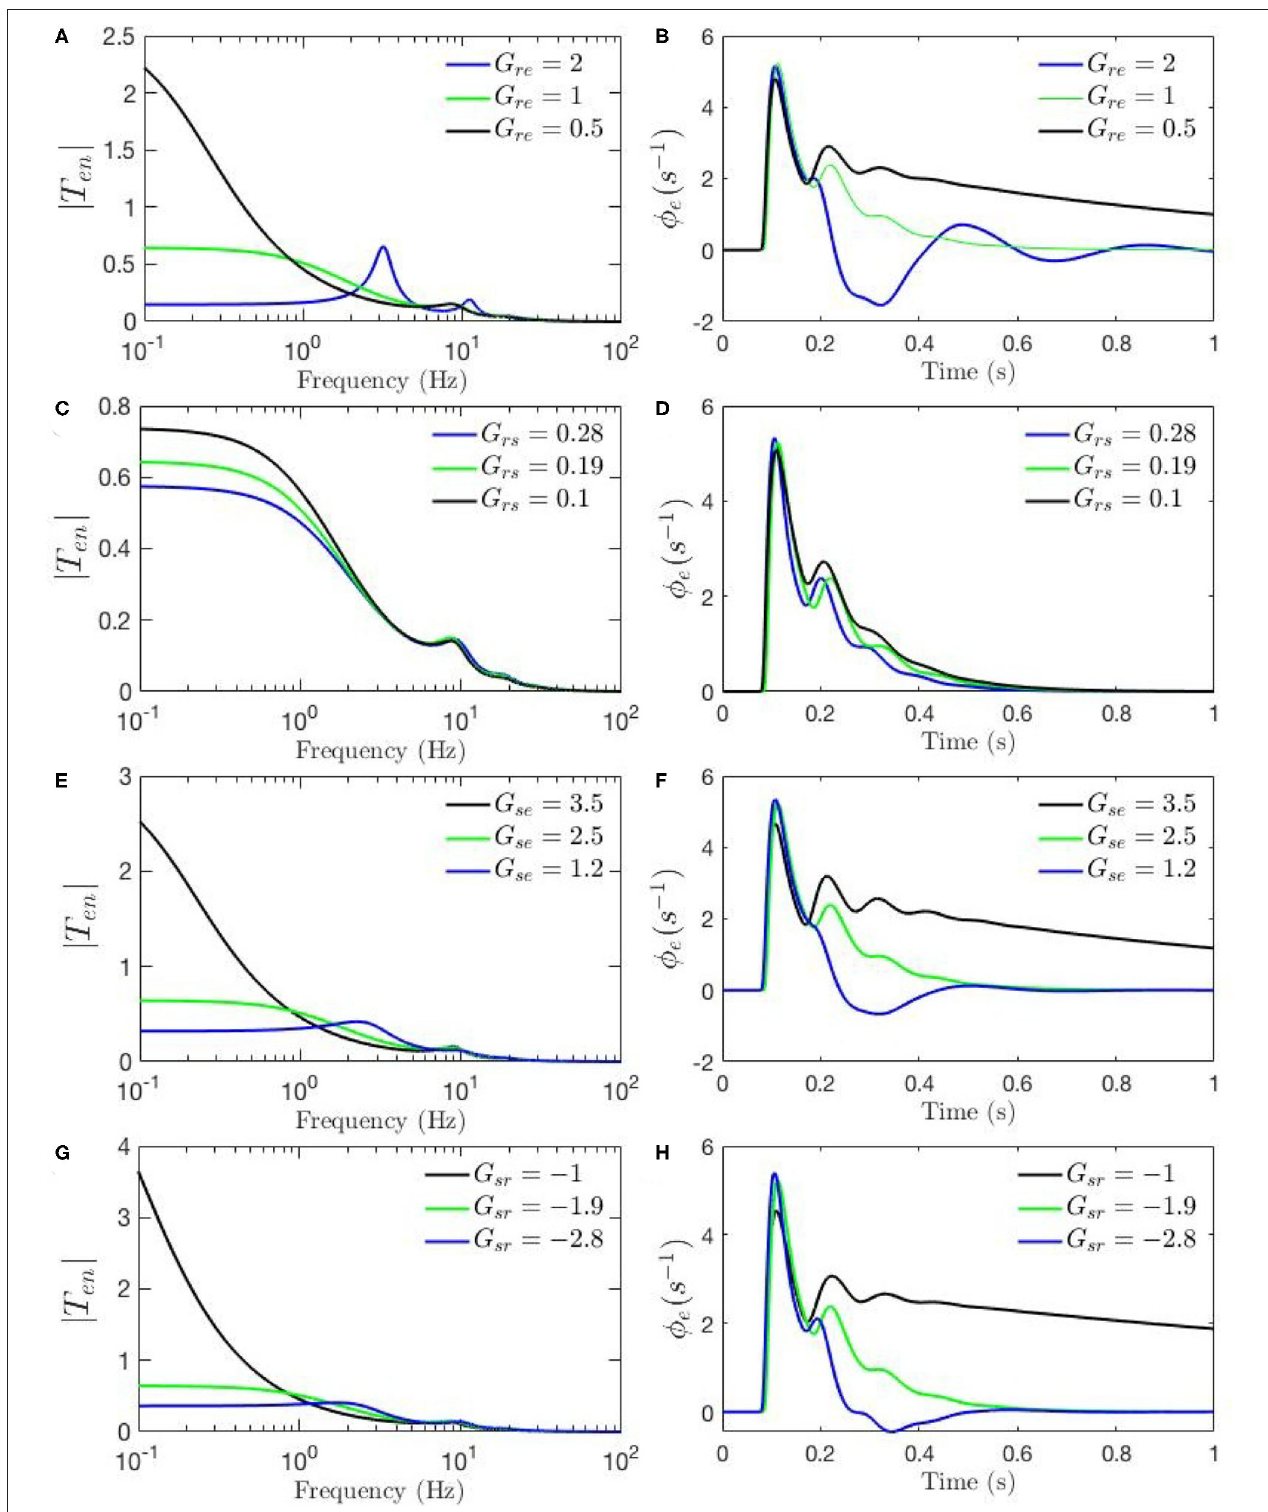
FIGURE 5 | Sensitivity analyses of ERPs to corticothalamic and thalamic gains calculated using the transfer function corresponding to nominal parameter values for eyes-open normal adults in resting state EEG (black), as listed in Table 1 . In each case one parameter is then changed to its value from the fixed-gain ERP set (blue), as also listed in Table 1 , and then in the opposite direction relative to the EEG values (green). The parameters varied are as follows, with the transfer function T in the left column of each row and the corresponding ERP in the right column: (A,B) G re . (C,D) G se . (E,F) G rs . (G,H) G sr .